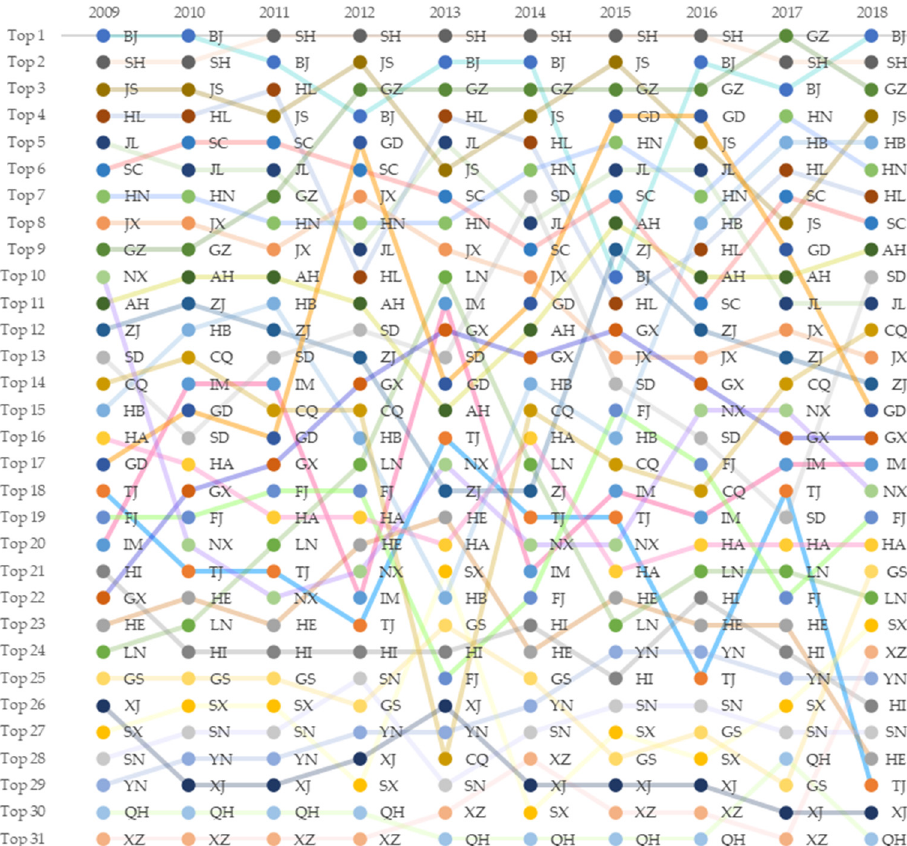
Figure 5. Ecological development value of the forestry industry in each province.